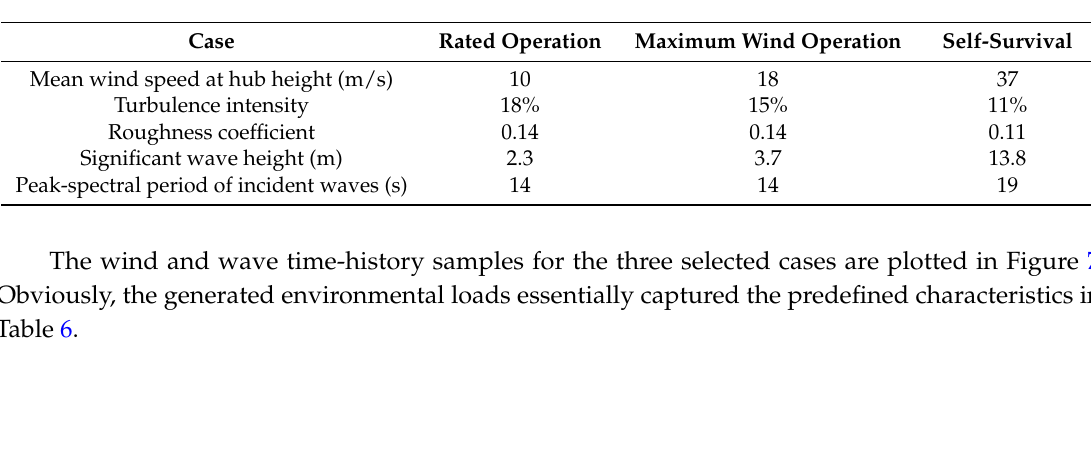
Table 6. Realistic environmental load